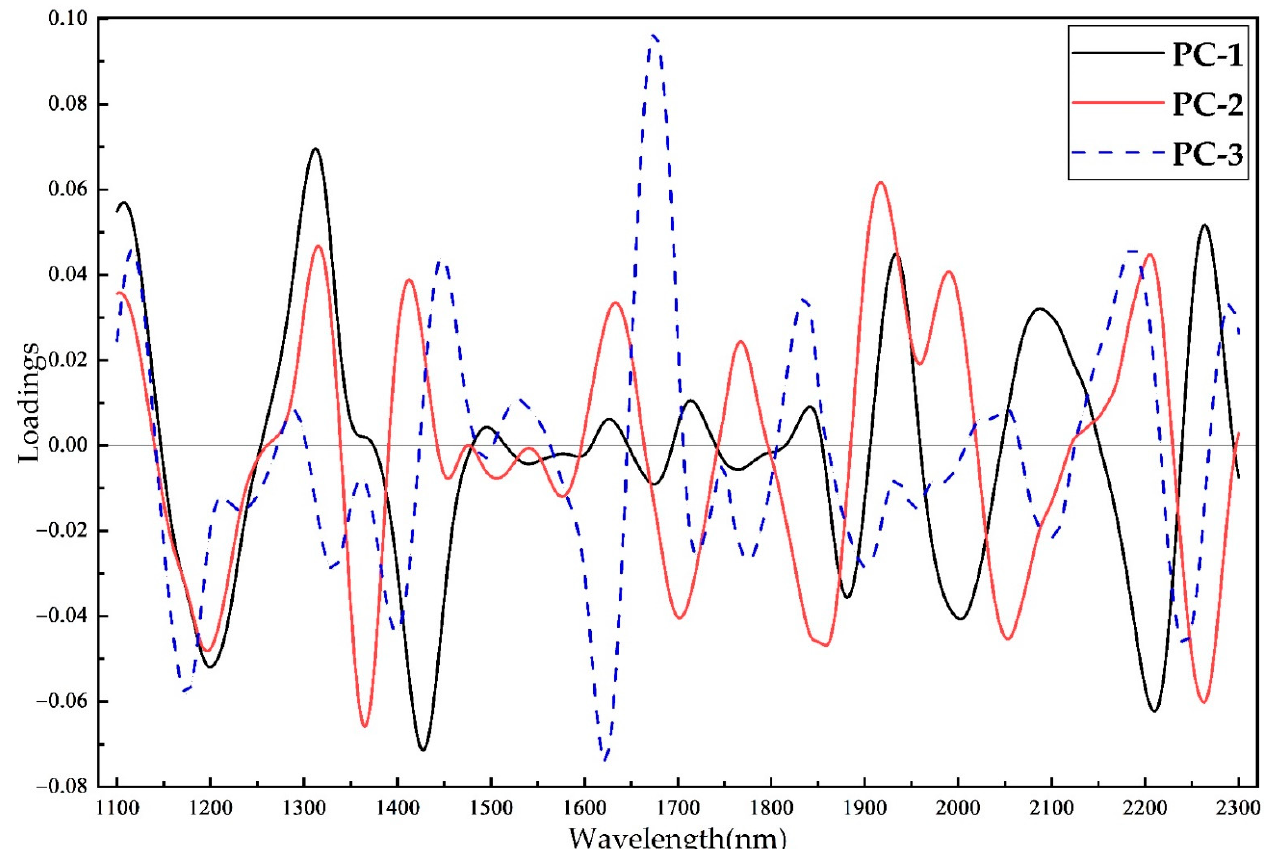
Figure 6. Loading spectra for principal components PC-1, PC-2, and PC-3. Table 6. Identification accuracy of the SVM model based on the NIR spectra fused with GLCM.